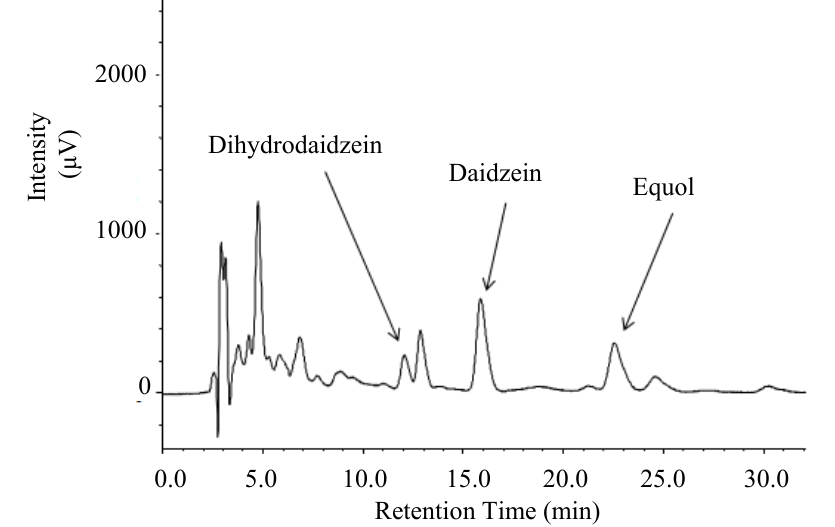
Figure 3. HPLC chromatogram of daidzein, dihydrodaidzein and equol obtained from urine of a mouse fed the XD diet at 280 nm. Peak identity was confirmed by rechromatography with the authentic compounds.